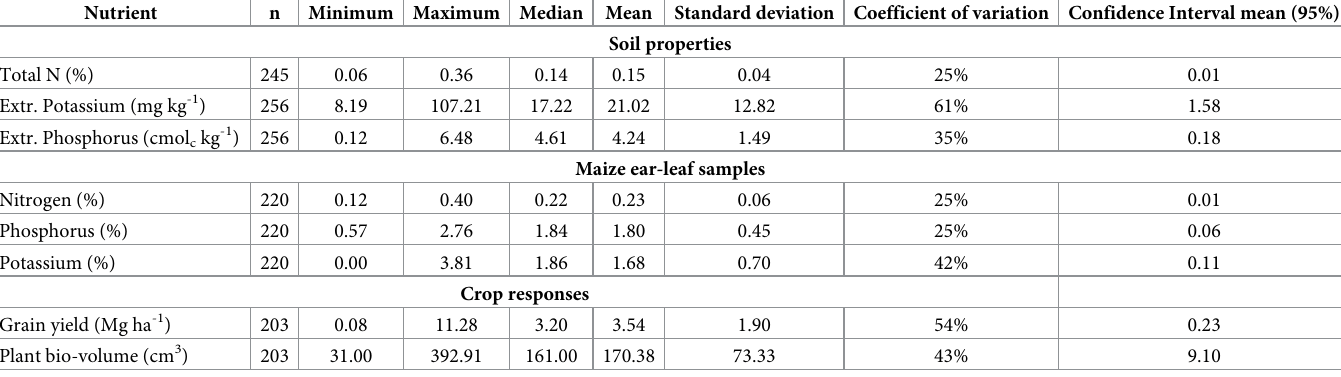
Table 3. Soil properties, maize ear leaf total tissue nutrient concentration and crop response variables of unfertilized maize plots across a smallholder agroecosys- tem in western Kenya.